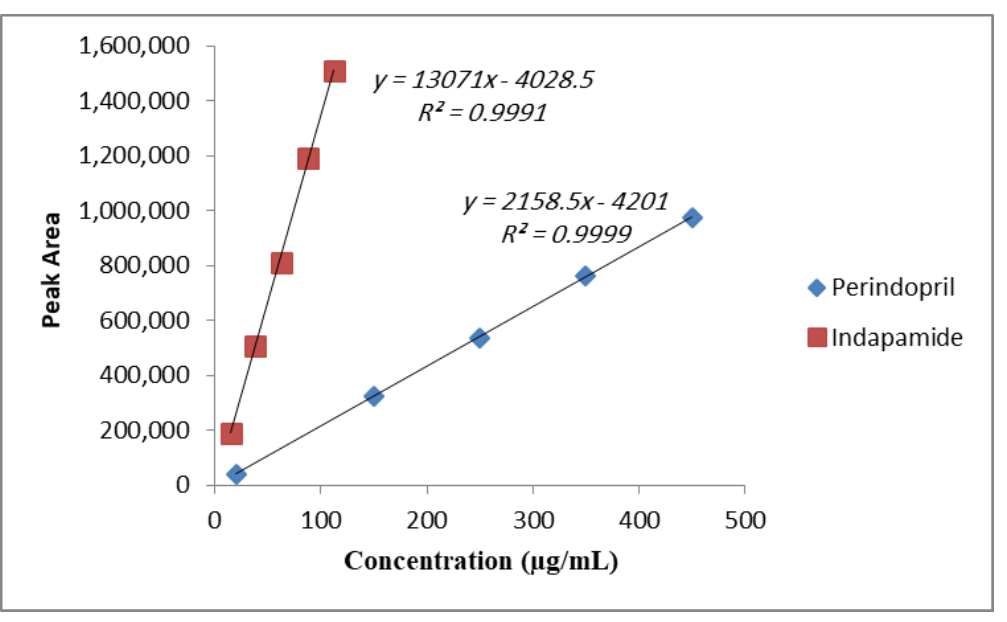
Figure 3. Calibration curve for Perindopril arginine and Indapamide hemihydrate.